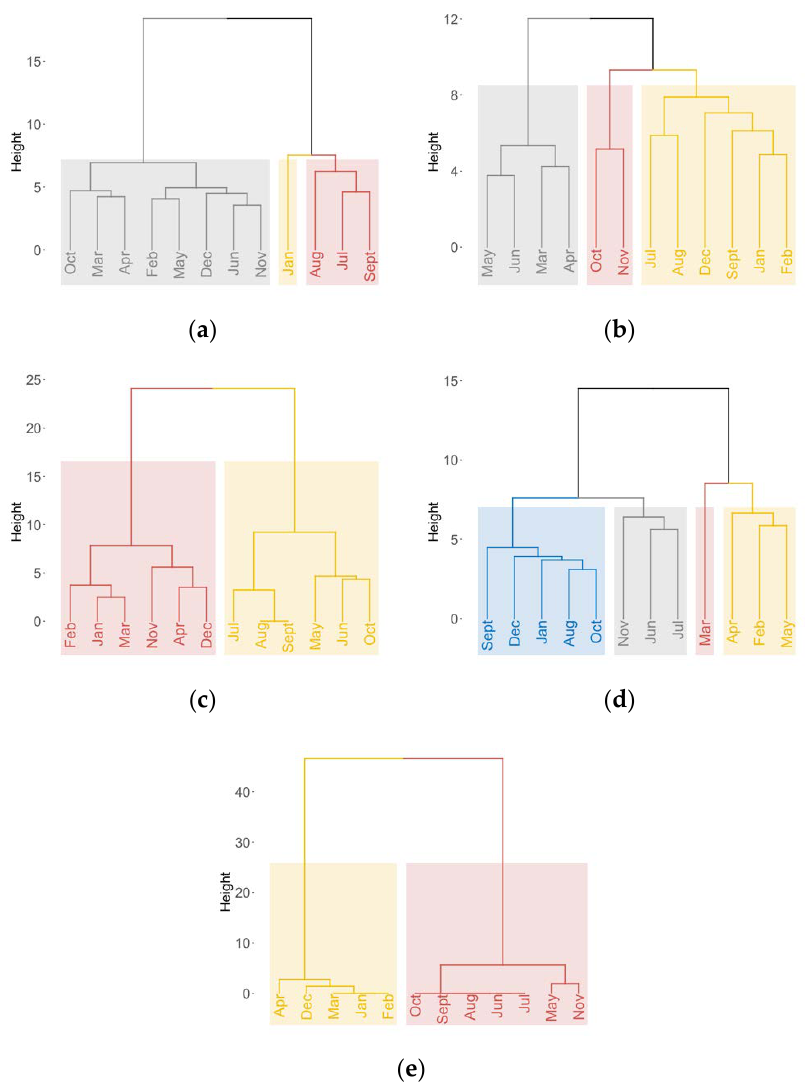
Figure 5. Cluster analysis of months with similar frequency of ( a ) cyclonic eddies; ( b ) anticyclonic eddies; ( c ) coastal upwelling; ( d ) filaments; ( e ) water mass intrusion in the Central Gulf of California. Colors of clusters represent highest to lowest frequency/presence of events in the following order: red, yellow, grey, blue.